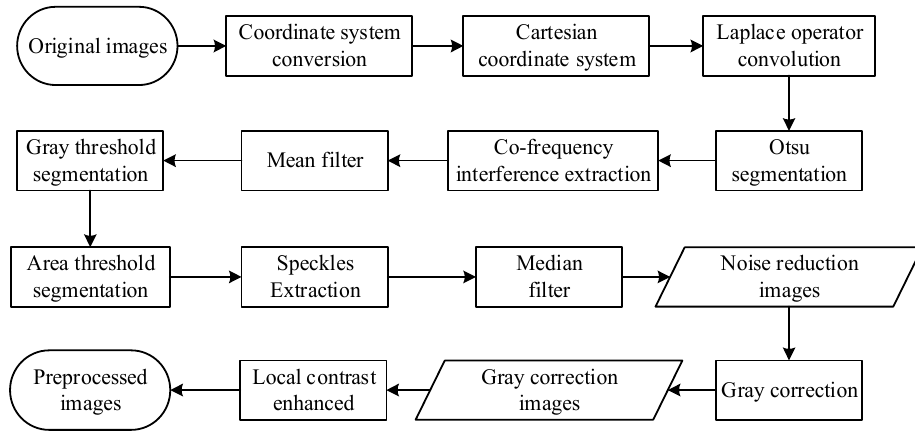
Figure 3. Data preprocessing scheme.